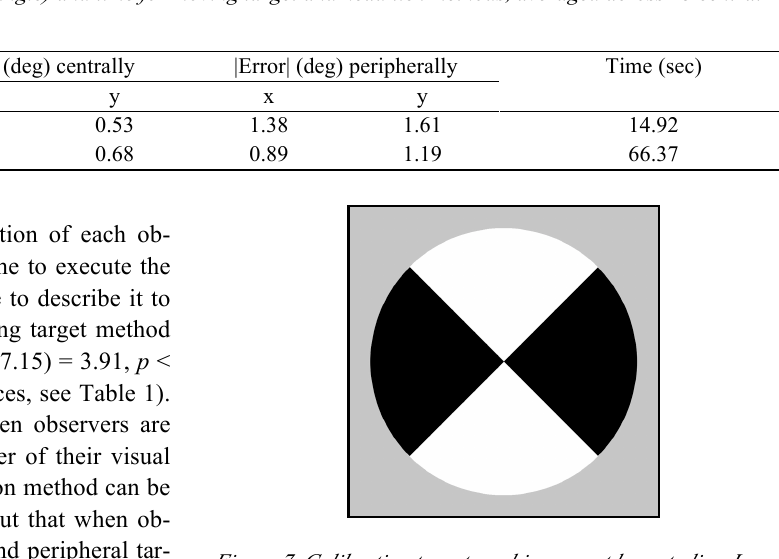
Figure 7. Calibration target used in our outdoor studies. In Figure 6, the target is pasted to a geologist’s field